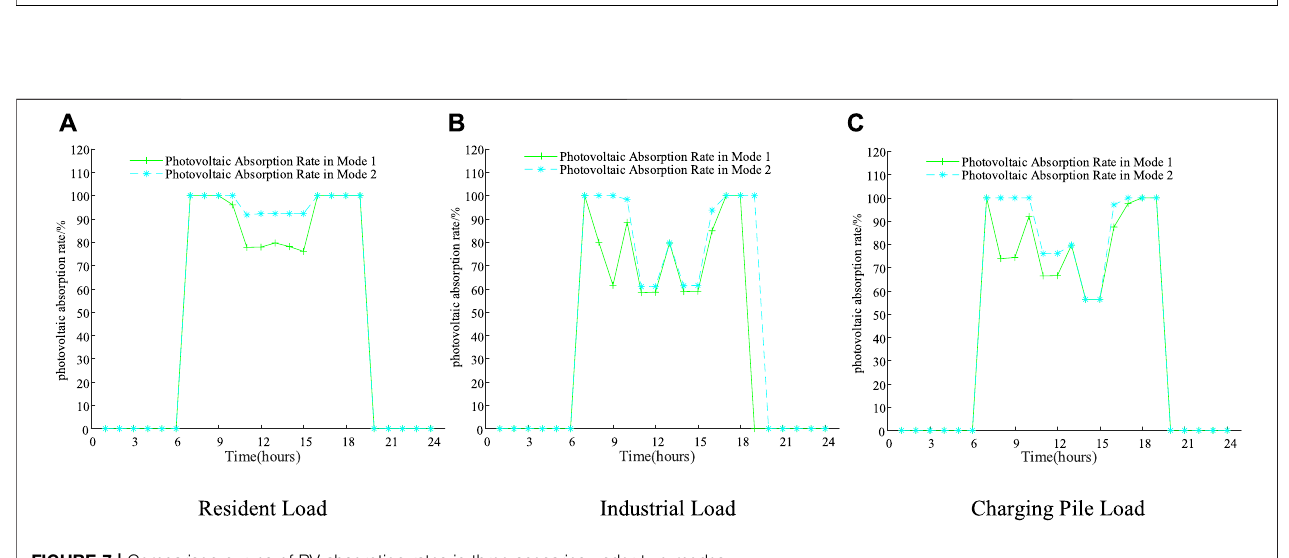
Frontiers in Energy Research |